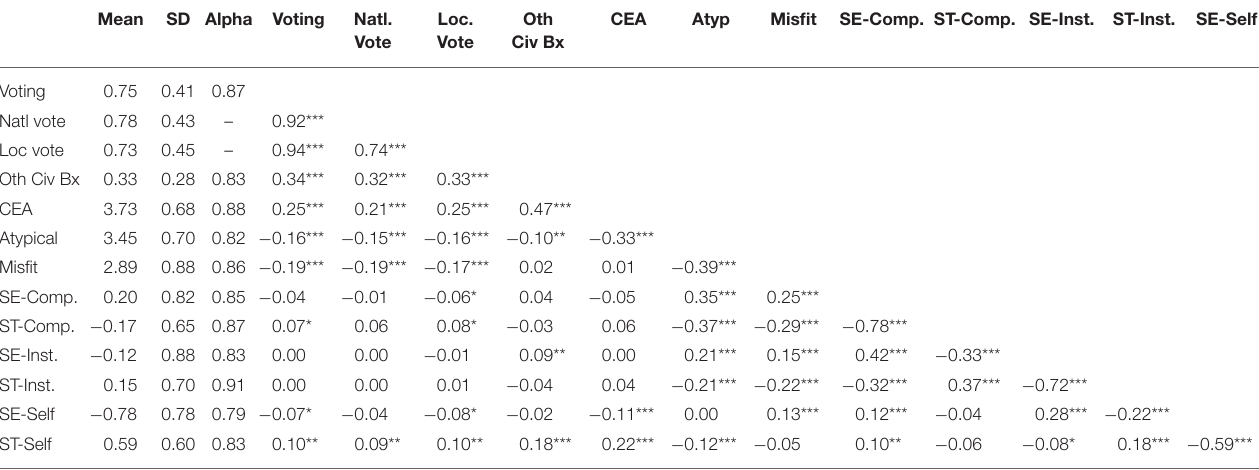
TABLE 4 | Descriptive statistics, Cronbach alphas, and correlations for study 3